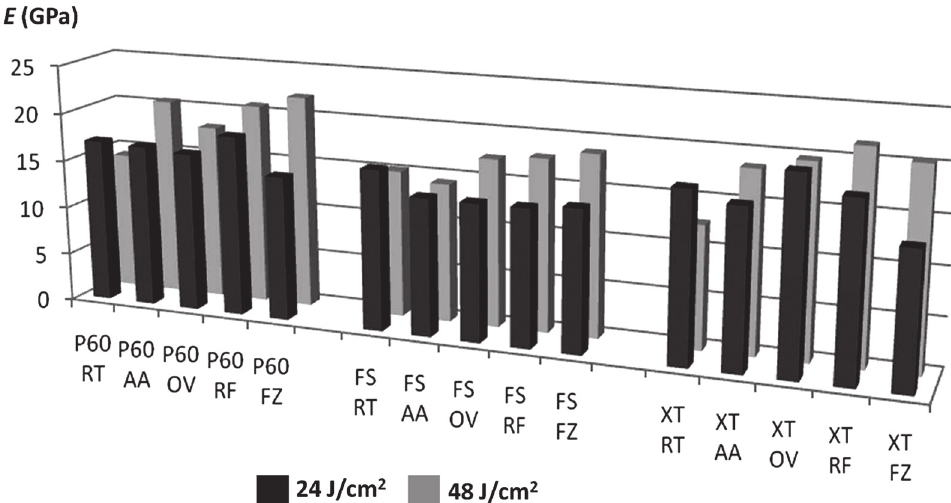
Figure 4- Graphic of flexural modulus (GPa) considering all factors: I. Composites: Filtek P60 (P60), Filtek Silorane (FS) and Filtek Z350XT (XT); II. Syringe storage conditions: Room Temperature (RT), Accelerated aging (AA), Oven 24 h (OV), Refrigerator 24 h (RF), Freezer 24 h (FZ); III. Energy doses: 24 J/cm 2 and 48 J/cm